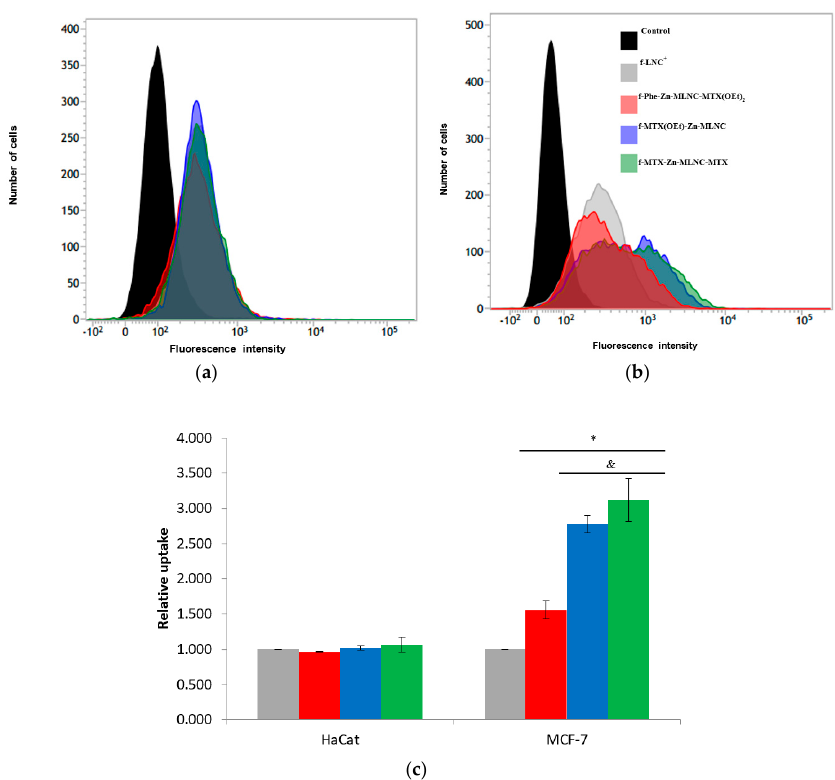
Figure 3. Flow cytometry plot showing the fluorescence intensity versus the number of cells for ( a ) HaCaT (spontaneously immortalized human epithelial cell line) and ( b ) MCF-7 (human breast carcinoma cells), in which the nanoformulations (color distributions) are compared ( p < 0.05) to the control (untreated cells, black distribution); ( c ) Histogram of the relative cellular uptake for f -LNC + (100%), f -Phe-Zn-MLNC-MTX(OEt) 2 , f -MTX(OEt) 2 -Zn-MLNC, f -MTX-Zn-MLNC-MTX. Data represent average ± SD ( n = 3). No significant difference among formulations ( p > 0.05) was determined for cellular uptake (ANOVA, Tukey). For MCF-7 cells, Phe, MTX and MTX(OEt) 2 -surface